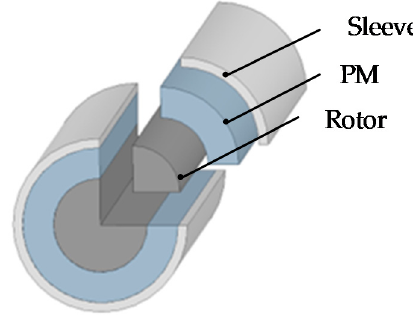
Figure 3. Finite element model of the rotor.